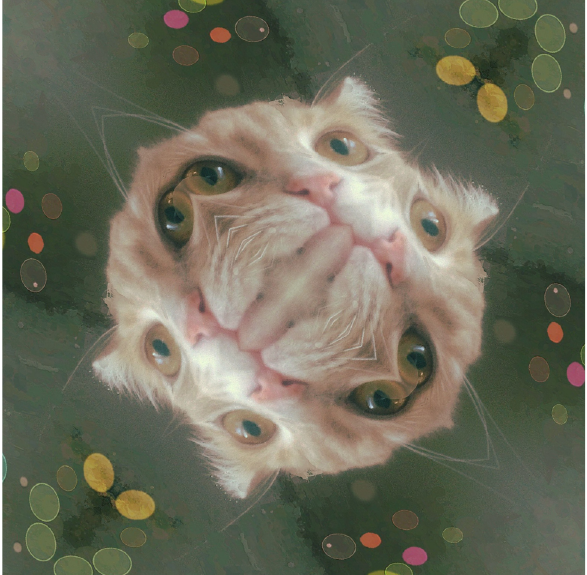
Figure 7 | “Eye ball”.